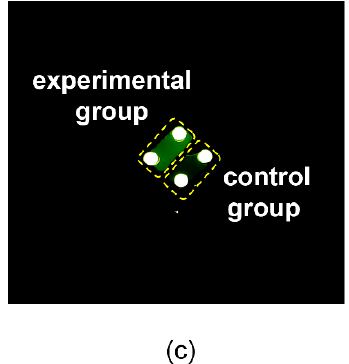
Figure 11. PCR amplification experiments with HPV16E6 genomic DNA. ( a ) Photograph of the portable PCR device and the experimental environment. ( b ) The temperature trace of the 40-cycle PCR condition for HPV16E6 genomic DNA. ( c ) The results obtained by our fluorescence detection system. There was significant fluorescence difference between the experimental group and the control group.